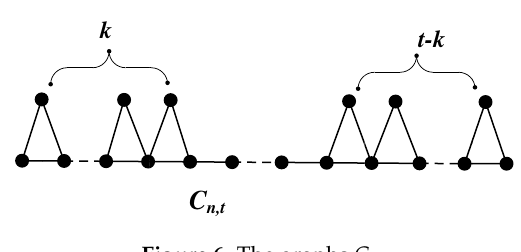
Figure 6. The graphs C n , t